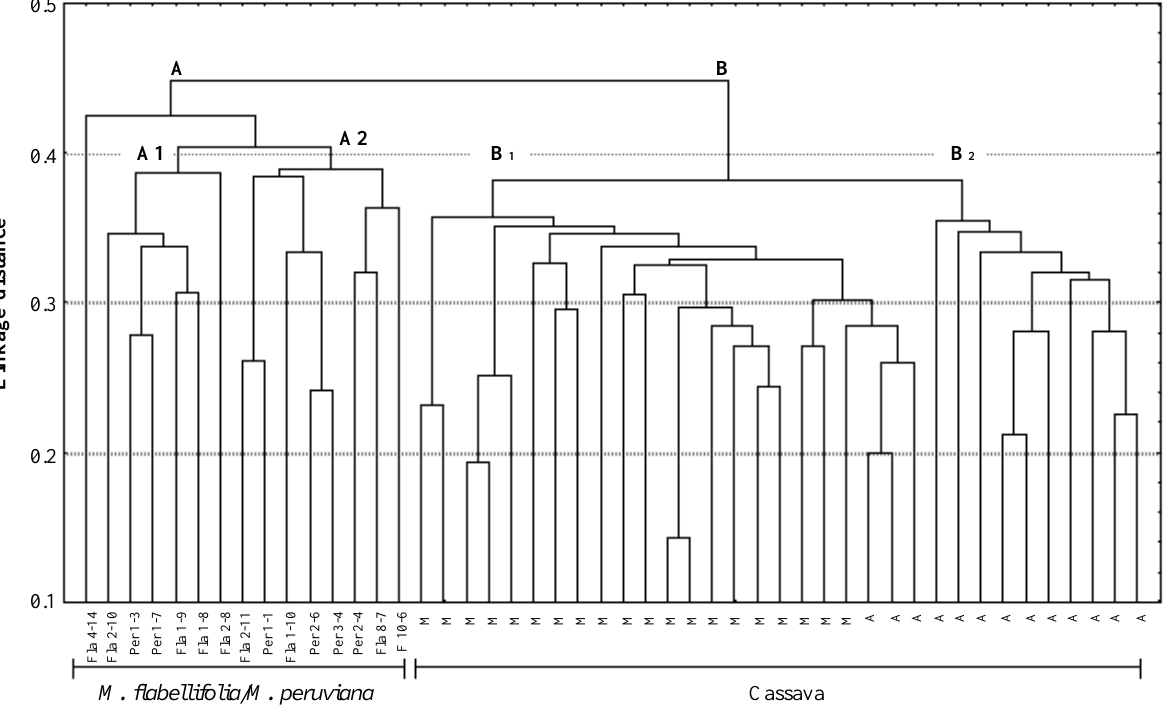
Figure 1 - Classification of M. esculenta (two groups, M for the samples of a world collection and A for samples from the Amazon region), M. flabellifolia and M. peruviana based on the UPGMA grouping method. The distances (similarity index of Jaccard (1908)) were calculated using the combined RAPD and AFLP data (92 and 73 markers, respectively).